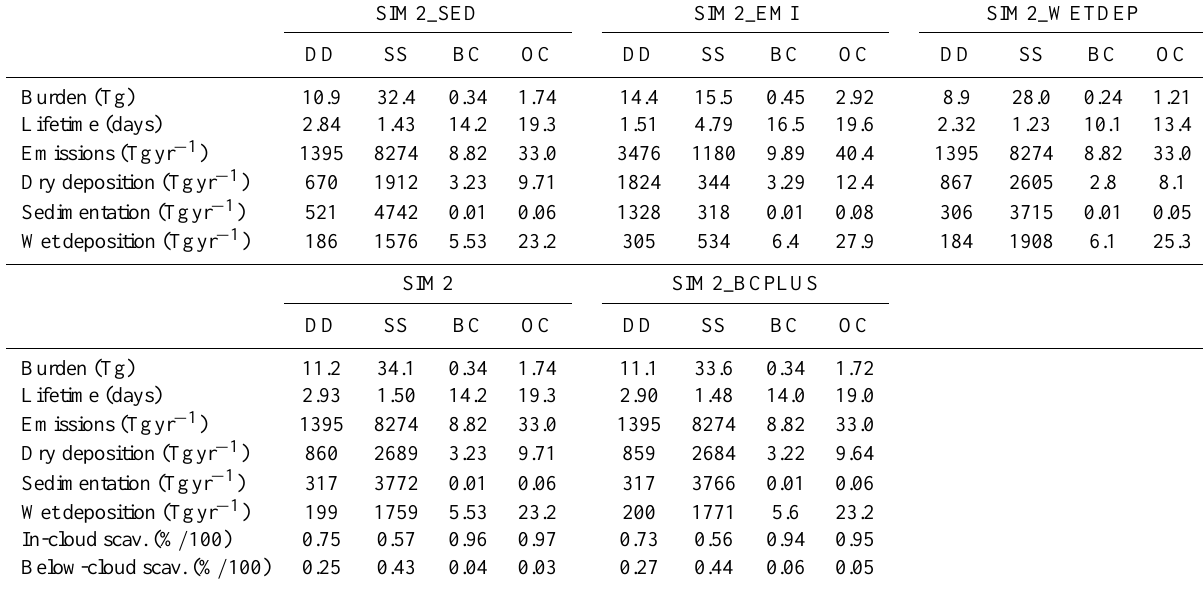
Table 5. Globally averaged annual burden, lifetime, emissions, and deposited mass due to wet deposition, dry surface deposition and sedi- mentation for different aerosol types (DD – desert dust, SS – sea salt, BC – black carbon, OC – organic carbon) in different model simulations to reveal the separate effects of different model updates. For a description of model simulations, see Table